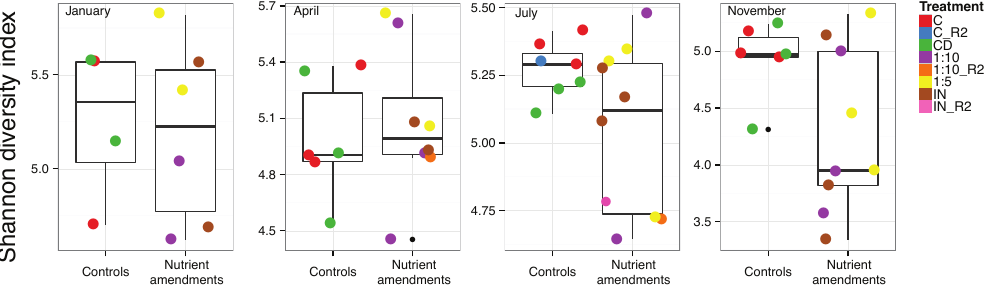
Figure 7. Differences in alpha-diversity, estimated from the Shannon index, between controls and nutrient amendment – i.e. all nutrient- amended treatments were binned and compared against all controls. Circles denote variation in alpha-diversity within the binned samples. Colours correspond to different treatments.